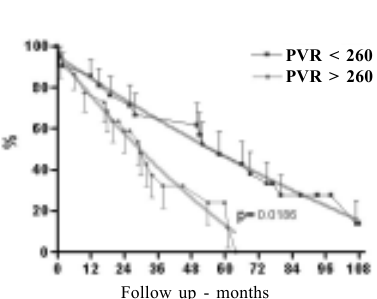
Fig. 4 - Actuarial survival curve (Kaplan-Meier) after dynamic cardiomyoplasty, according to the pulmonary vascular resistance level (PVR). P-value was calculated by the log-rank test.